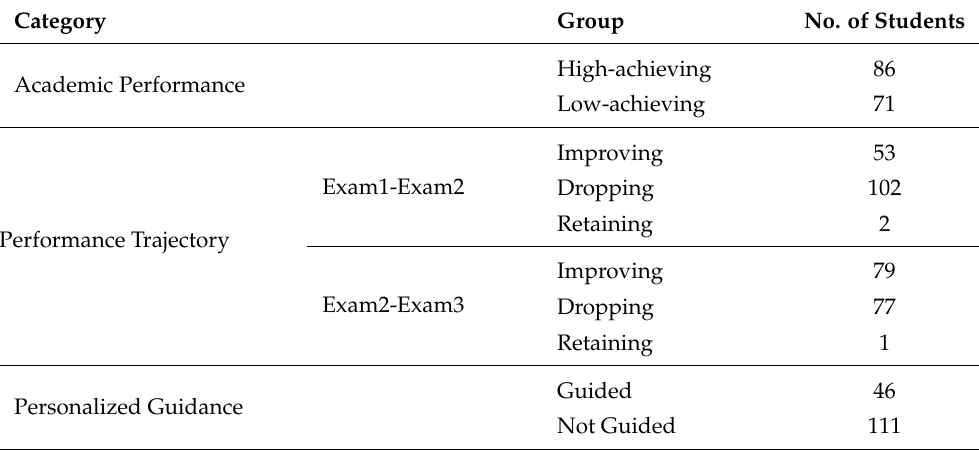
Table 1. Students were grouped based on several categories, namely in terms of their (1) academic performance, (2) performance trajectory in a given period, and (3) use of the system’s personalized guidance